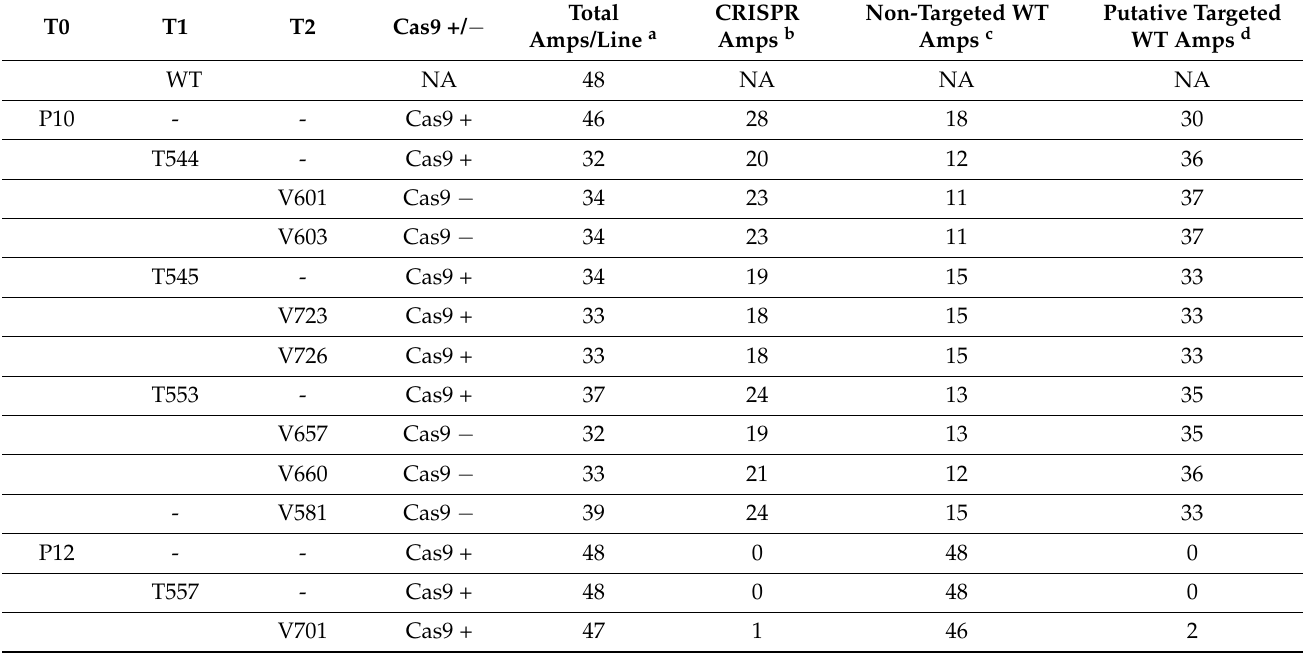
Table 3. Total number of Amps (frequency > 0.3%) detected for each T0 line and their T1 and T2 offspring lines from the hexaploid BW208 genotype. We also represented the number of CRISPR Amps, non-targeted WT Amps, and putative targeted WT Amps per line. The number of Amps for the WT has been calculated as the mean of all WT